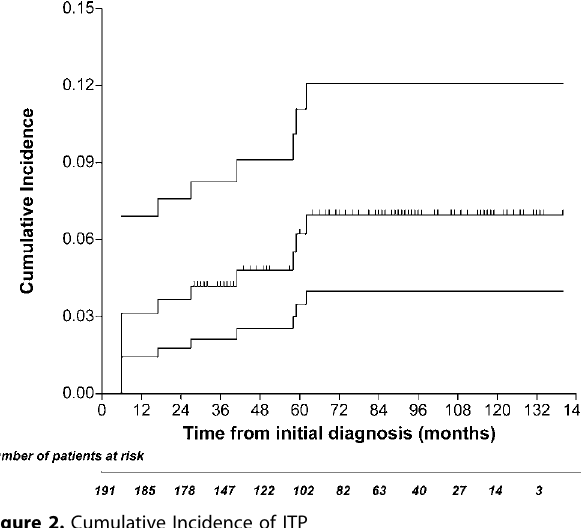
Figure 2. Cumulative Incidence of ITP The upper and lower lines indicate the 95% confidence limits. DOI: 10.1371/journal.pmed.0030024.g002